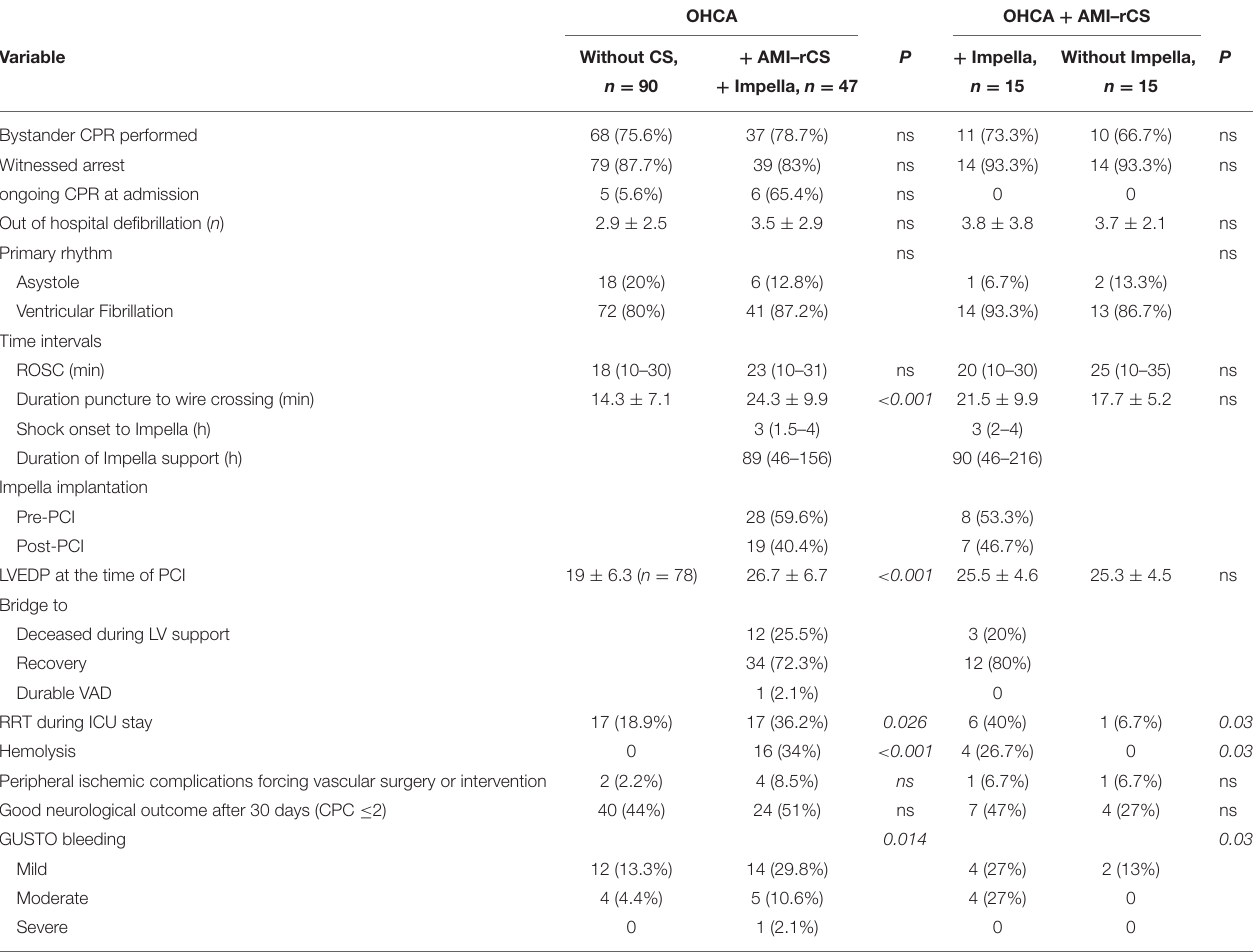
TABLE 2 | ICU course and complications of propensity score-matched cohorts.